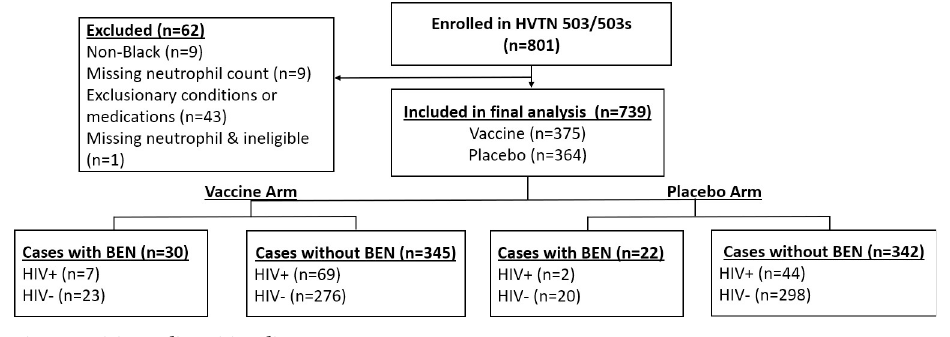
Fig 1. Participant disposition